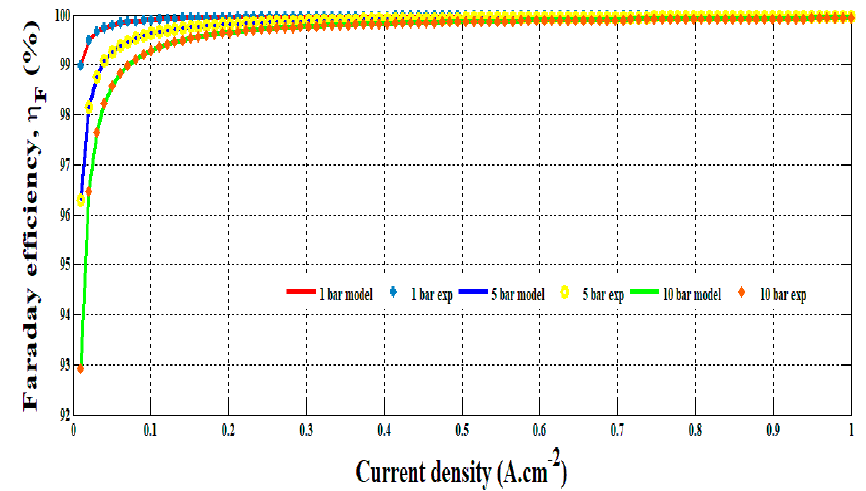
Figure 7. Comparison of the experiments and the model for 1, 5 and 10 bar.